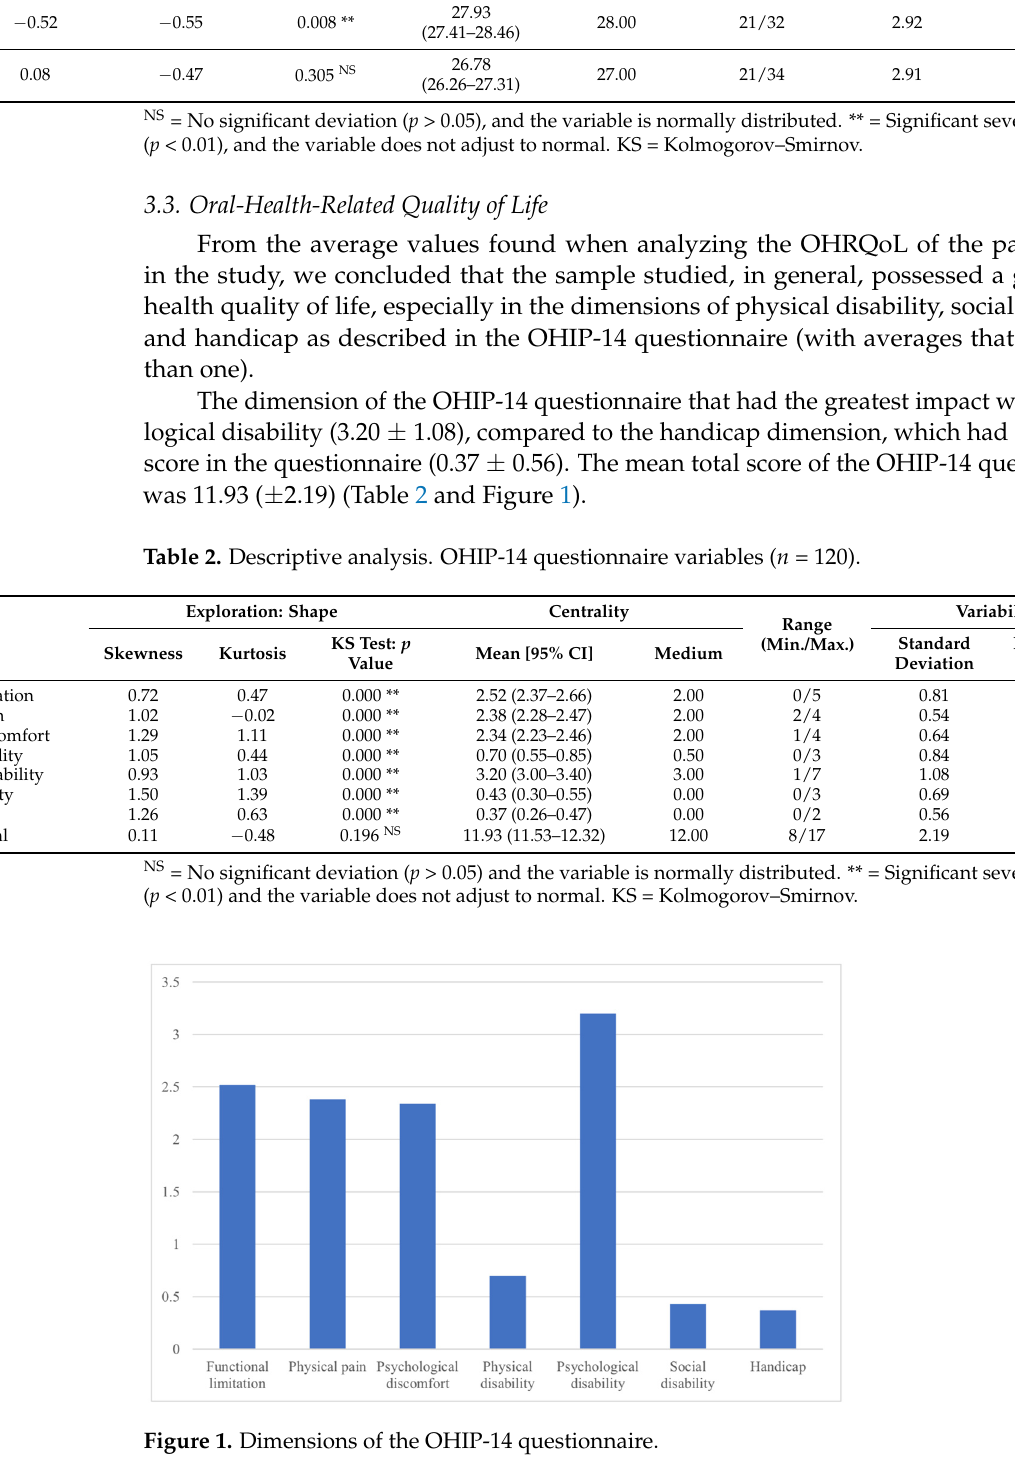
Table 3. Inferential Analysis. Intergroup comparison of OHIP-14 and STAI variables based on sex ( n = 120). Variables